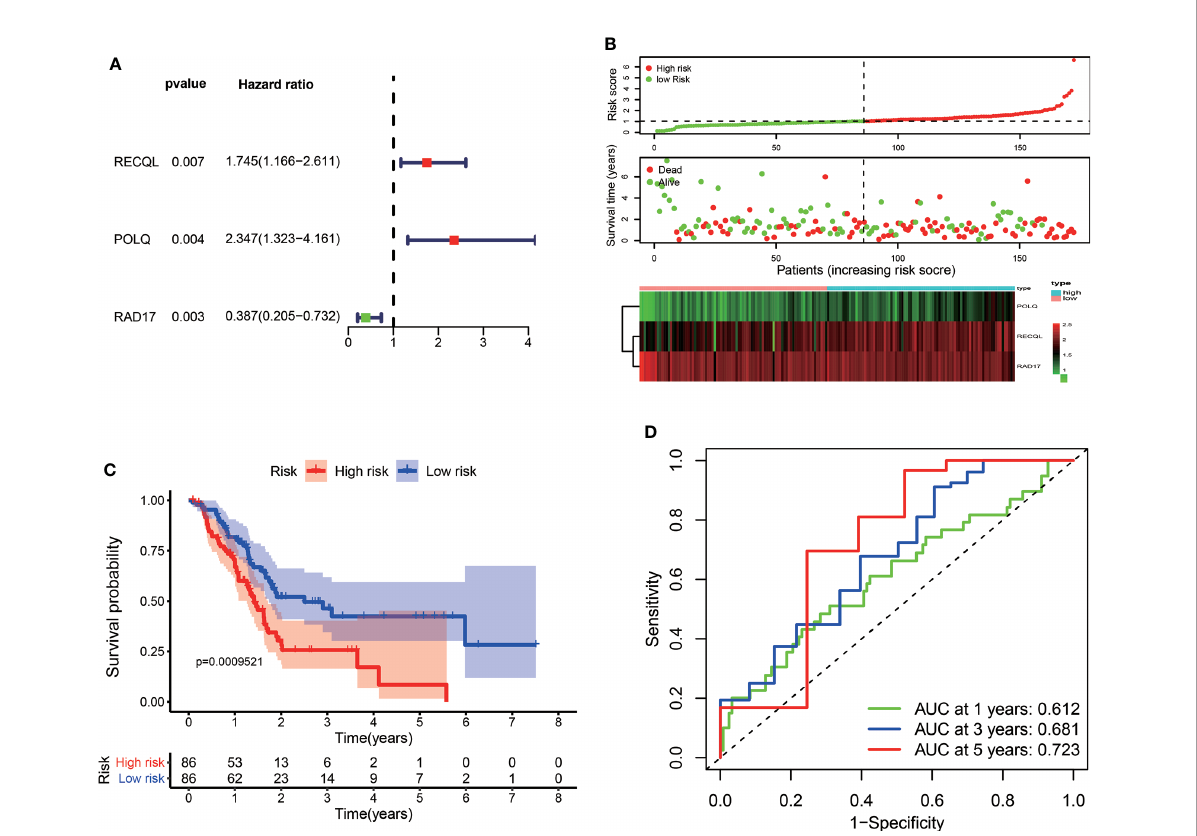
FIGURE 1 Construction of a prognostic signature for PAAD patients based on three DRGs. (A) Forest plot of the multivariate Cox regression analysis in the TCGA dataset. The red dots represented high-risk genes, while the green dots indicated low-risk genes. (B) The distribution of the risk scores, survival status, and expression pro fi le of three DRGs between high-risk and low-risk groups. (C) Kaplan – Meier survival curves of OS between high- risk and low-risk groups. (D) The time-dependent ROC for 1-year, 3-year, and 5-year OS predictions for the DRG signature in the TCGA